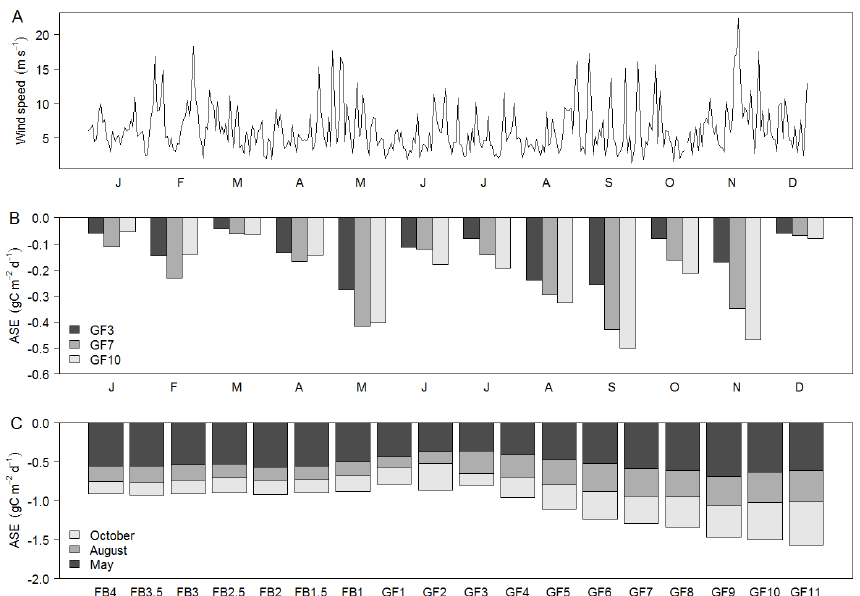
Figure 8. (a) Mean daily wind speed (ms − 1 ) at the meteorological station in Nuuk. (b) Time series of mean monthly air–sea CO 2 flux (ASE, gCm − 2 d − 1 ) at three stations (GF3, GF7 and GF10) in the fjord. (c) Mean ASE (gCm − 2 d − 1 ) from three cruises in the fjord system from the shelf (Fyllas Banke, left) to inner fjord glaciers